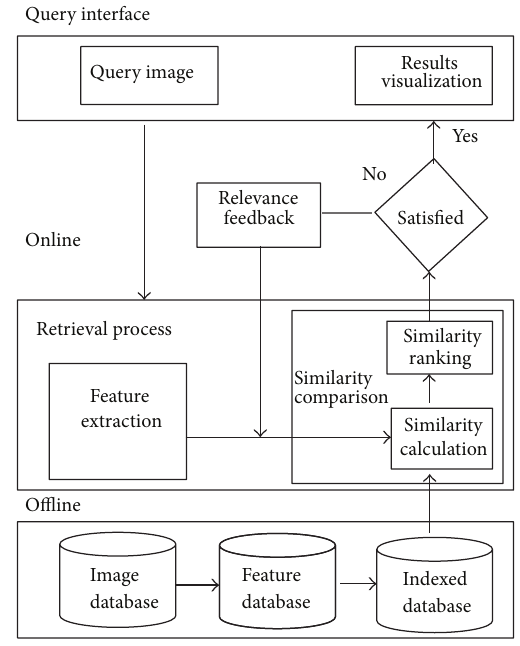
Figure 1: Typical framework of CBIR